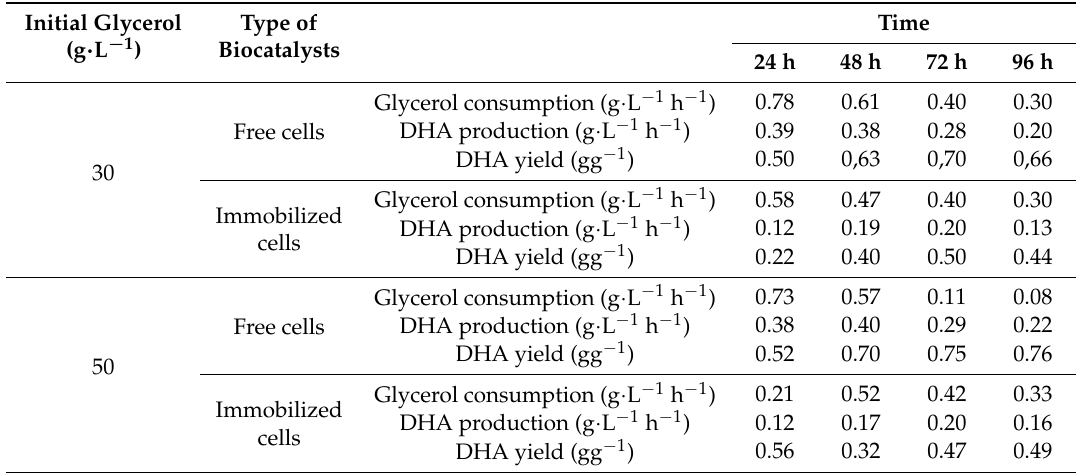
Table 2. Rates of glycerol consumption, DHA production, and DHA yield during bioconversion of a waste glycerol fraction (30 or 50 g · L − 1 ) with free and immobilized cell extracts. Initial Glycerol (g · L − 1